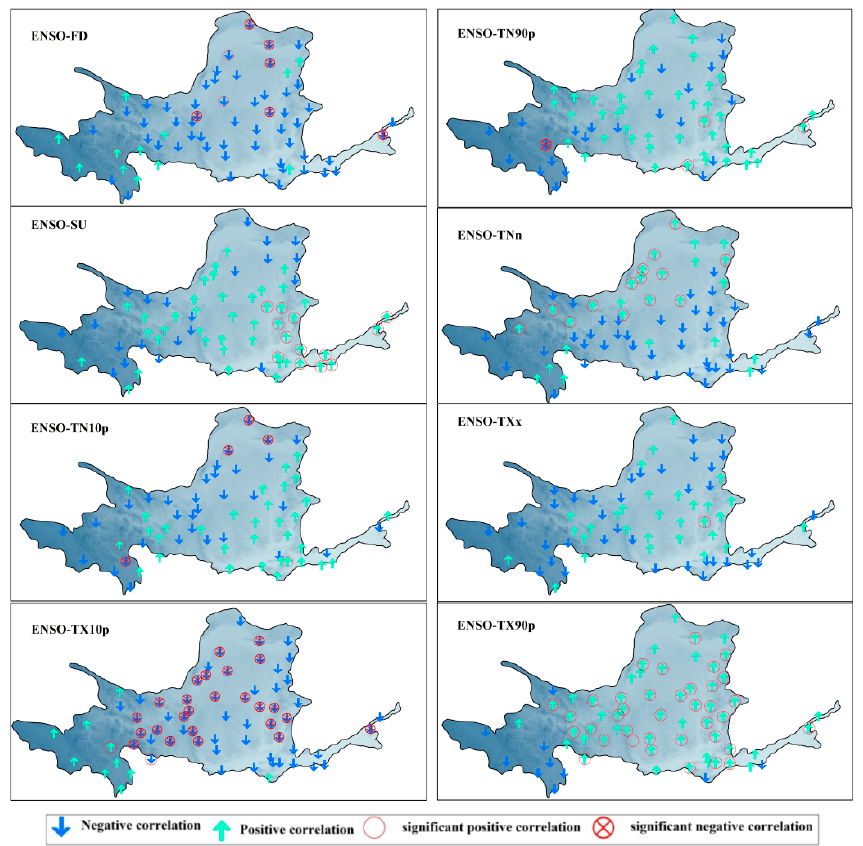
Figure 4. The potential connection between temperature extremes and the El Niño–Southern Oscillation (ENSO).